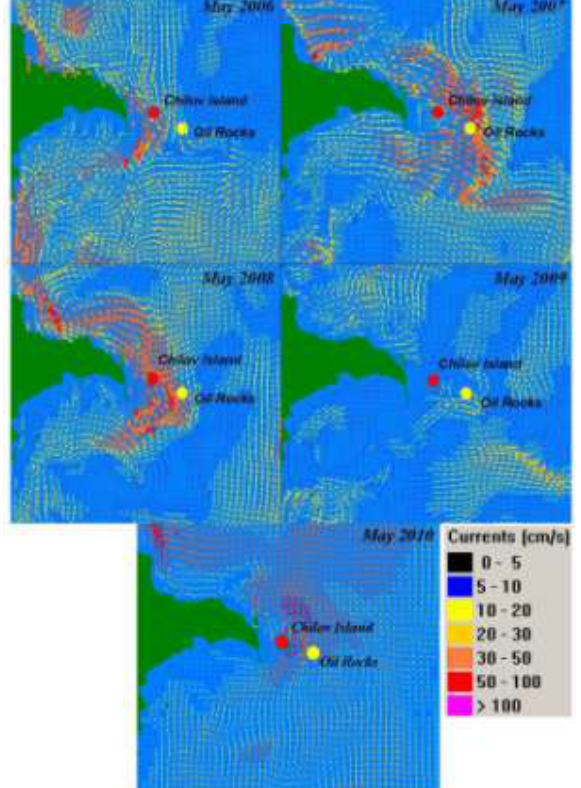
Figure 16. Linear regression analysis between contamination probability and oil spill